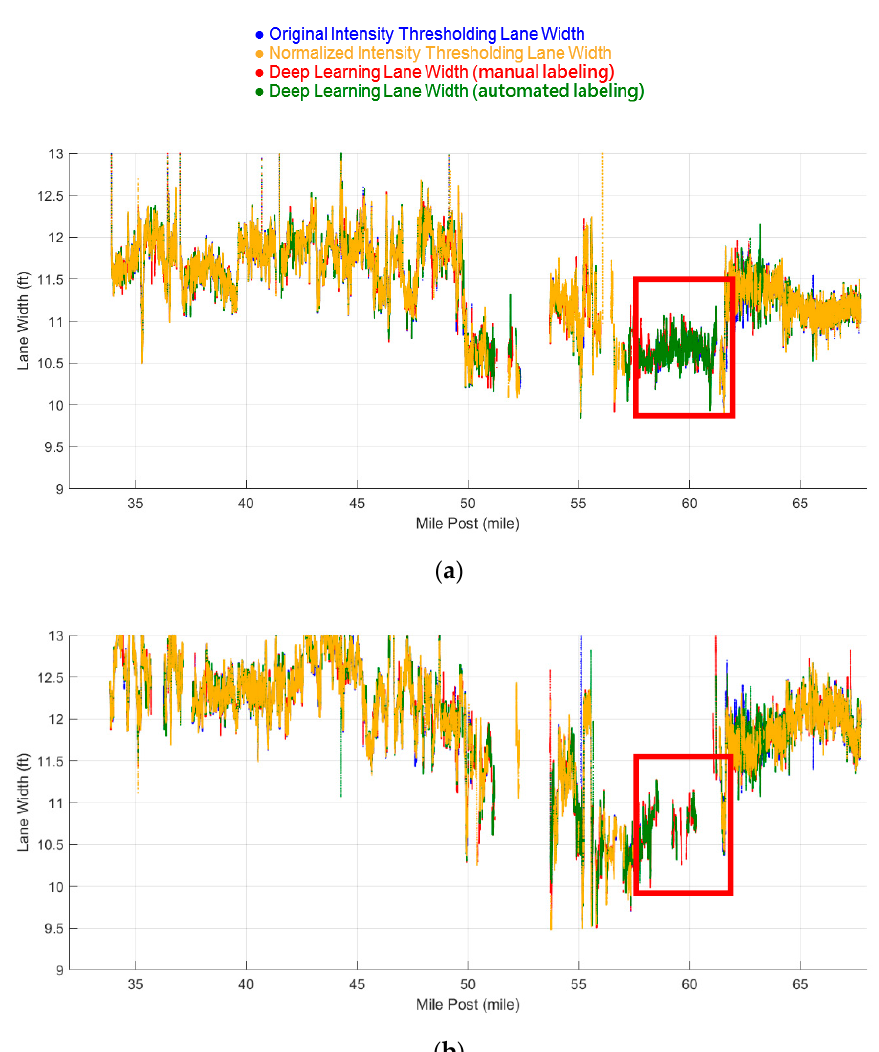
Figure 29. Estimated lane width values in ( a ) lane 1 and ( b ) lane 2 for dataset 2.